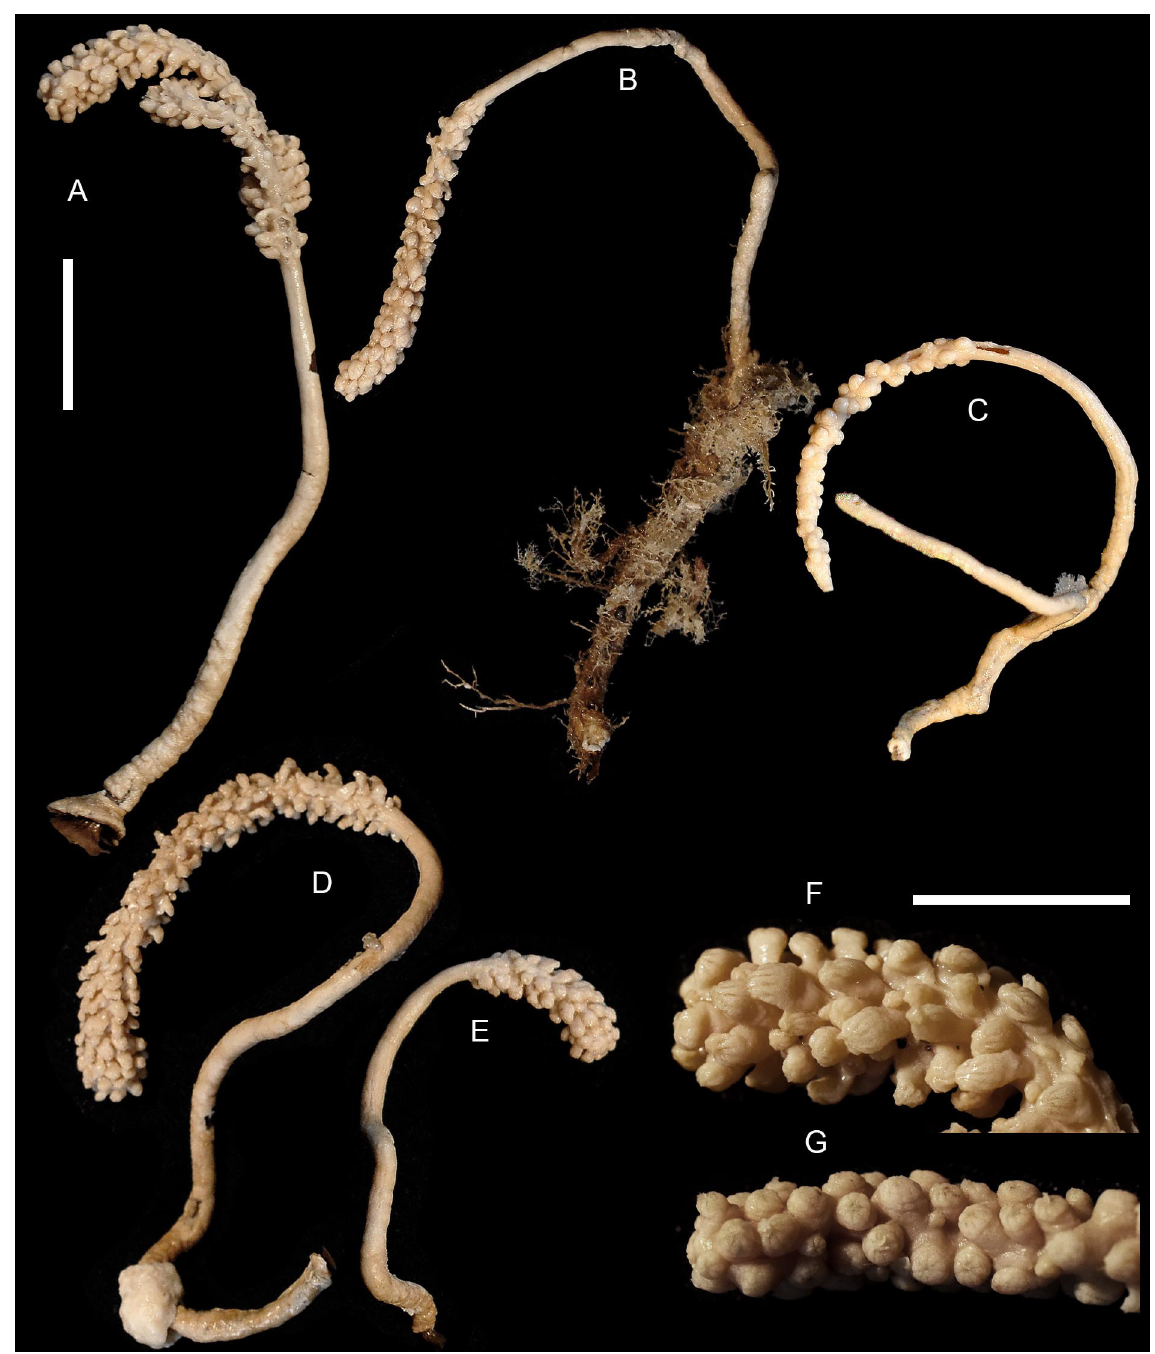
Fig. 1. Calcigorgia herba sp. nov. A . Holotype MIMB 20744, Kurile Islands, Sea of Okhotsk. B . Paratype MIMB 20745, Kurile Islands, Sea of Okhotsk. C . One specimen, Kurile Islands, Sea of Okhotsk, MIMB 20709. D–E . Two specimens, Kurile Islands, Sea of Okhotsk, MIMB 20748. F . Terminal polyps, holotype MIMB 20744. G . Terminal polyps, paratype MIMB 20745. Scale bars: A–E = 20 mm; F–G = 10